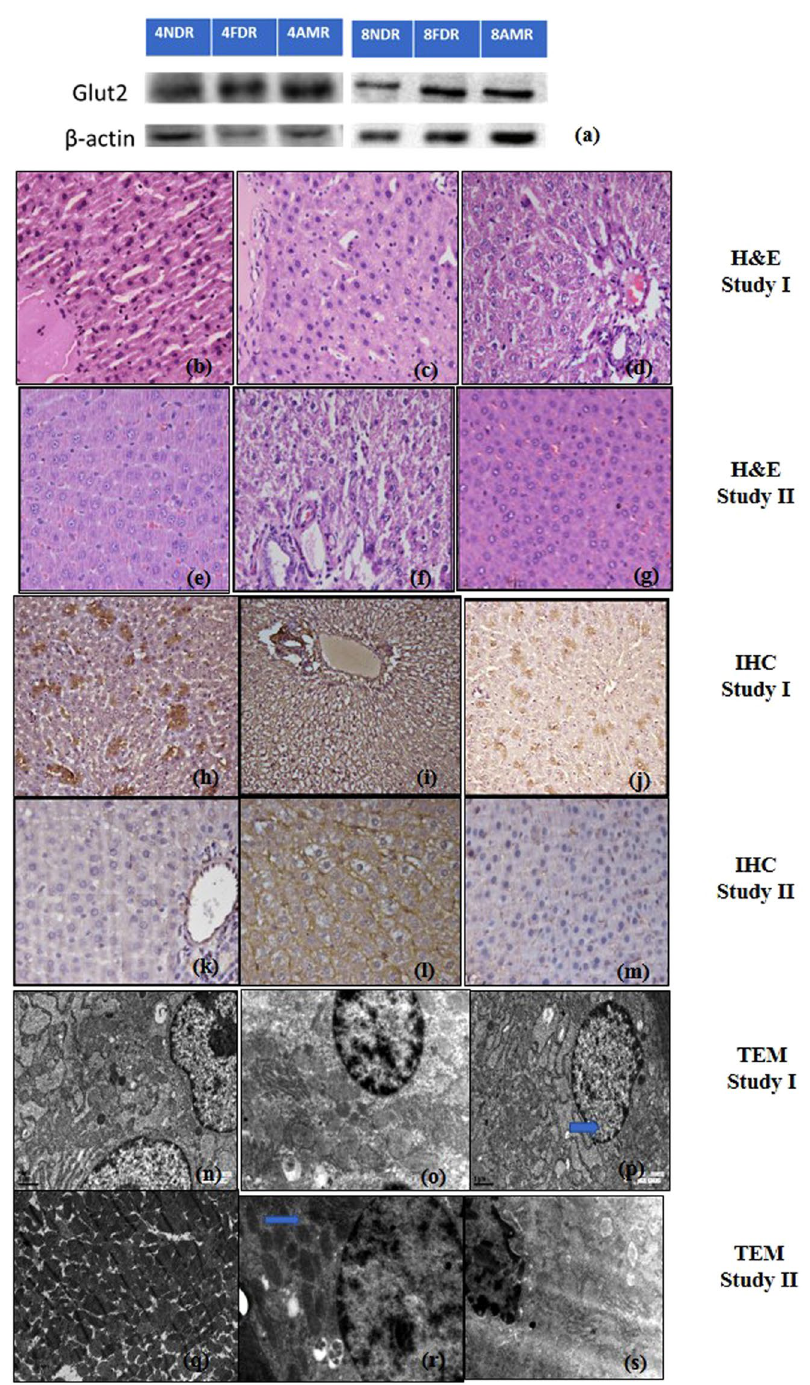
Figure 5. Comparative hepatic photomicrographs of western blot of glucose transporter (Glut2) protein, histopathology of parenchyma sections, immunohistochemistry of GLUT 2 protein and Transmission Electron Microscopy of hepatocytes, after 4 weeks(study I) and 8 weeks (study II) of fructose ingestion. The hepatic photomicrographs of western blot of glucose transporter (Glut2) protein, histopathology of parenchyma sections(H&EX200), immunohistochemistry of GLUT 2 protein and Transmission Electron Microscopy of hepatocytes in normal, fructose-control and AM-HM treated groups documents the histological, cellular and sub-cellular morphological changes brought about by fructose at developing ( a–d,h–j,n–p ) and adulthood ( a,e,f,g,k–m,q–s ) stages. The full-length blots/gels are presented in Supplementary